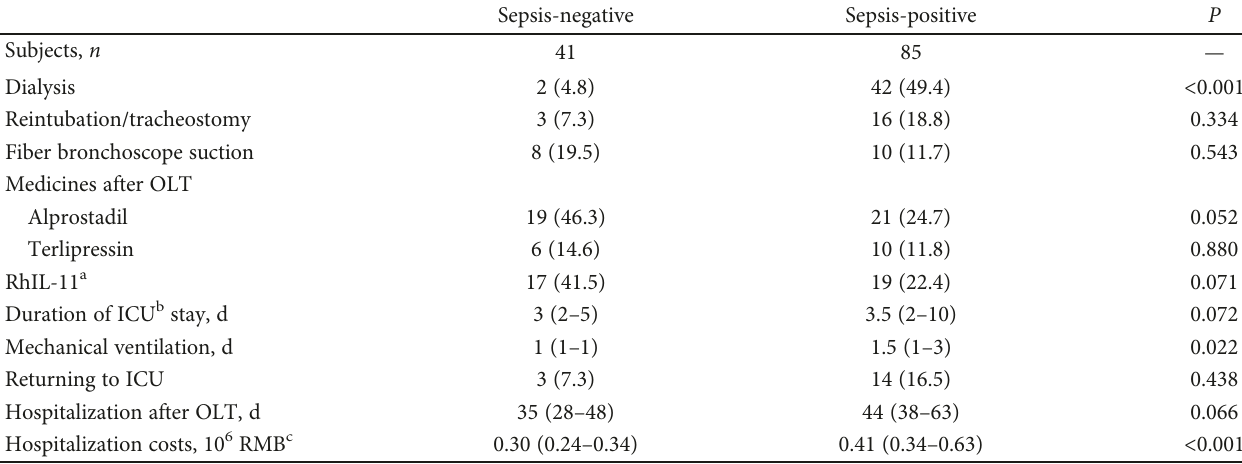
Table 2: Prognosis of patients with or without orthotopic liver transplantation- (OLT-) related sepsis (reported as n (%), unless otherwise